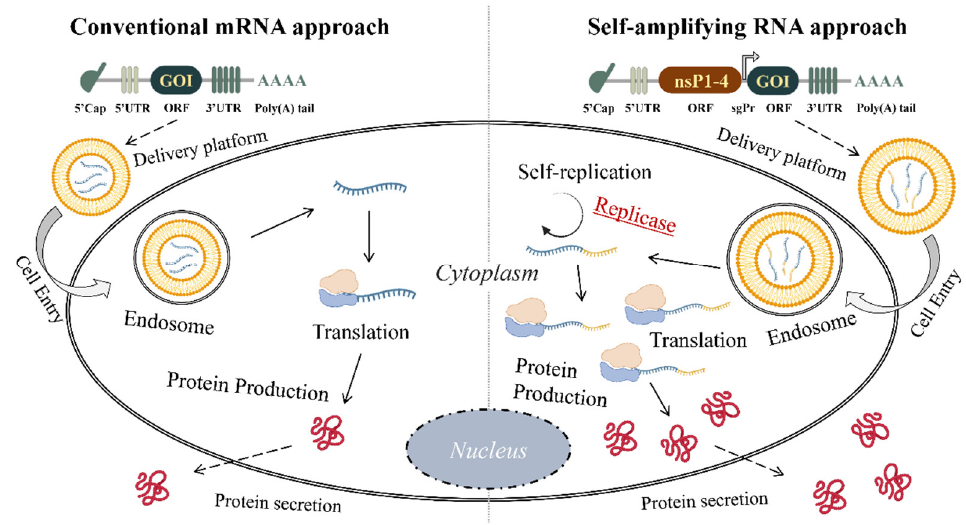
Figure 1. Protein production via mRNA and saRNA approaches. UTR, untranslated region; GOI, gene of interest; ORF, open reading frame; nsP1-4, non-structural protein 1-4; sgPr, subgenomic promoter.